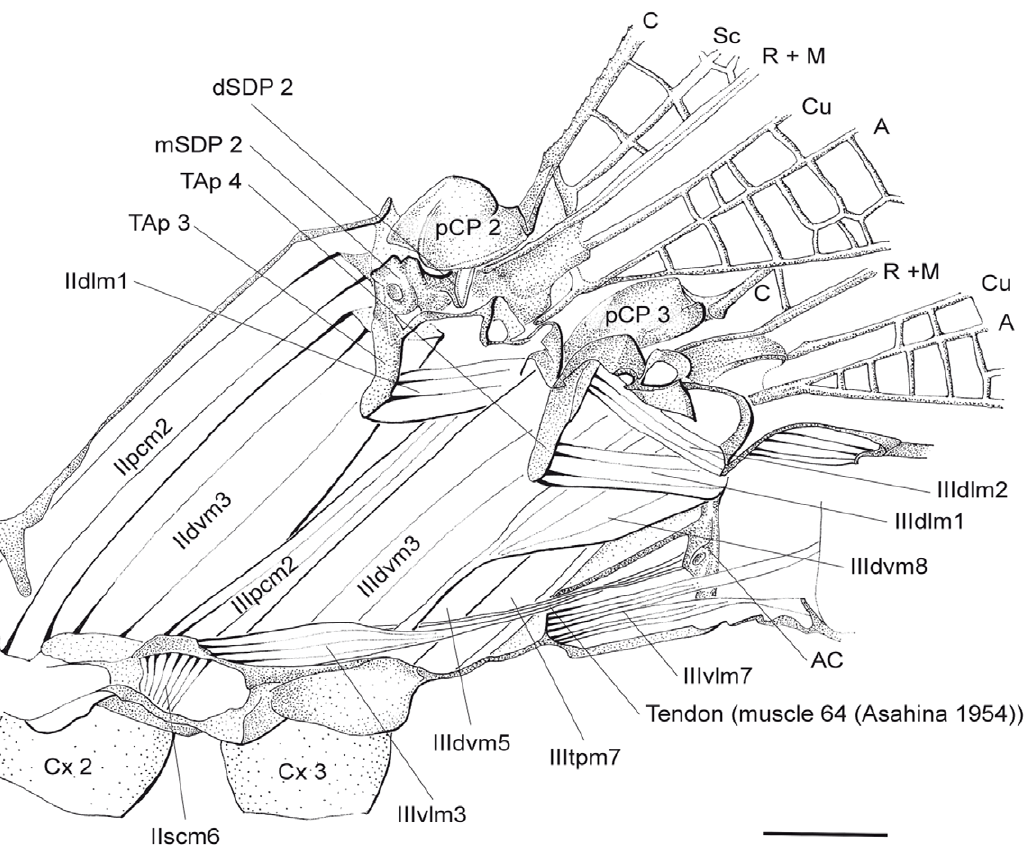
Figure 9. C.splendens , innermost layer of thorax musculature. Longitudinal cut, right. Abbreviations: A – anal vein, AC – antecosta, C – costa, Cu – cubitus, Cx – coxa, dSDP - distal semi-detached scutal plate, M – media, mSDP - mediane semi-detached scutal plate, pCP –